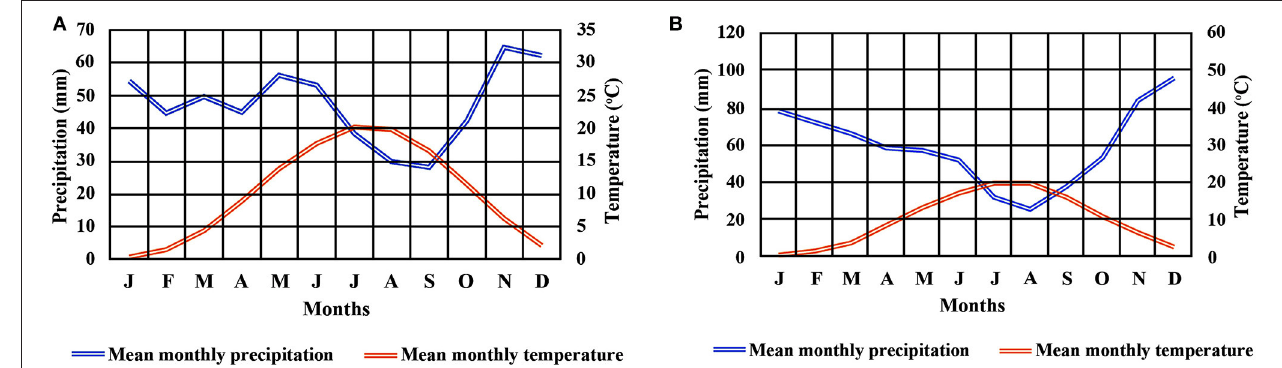
FIGURE 2 | Climate diagram for provenances Drama (A) and Evros (B)